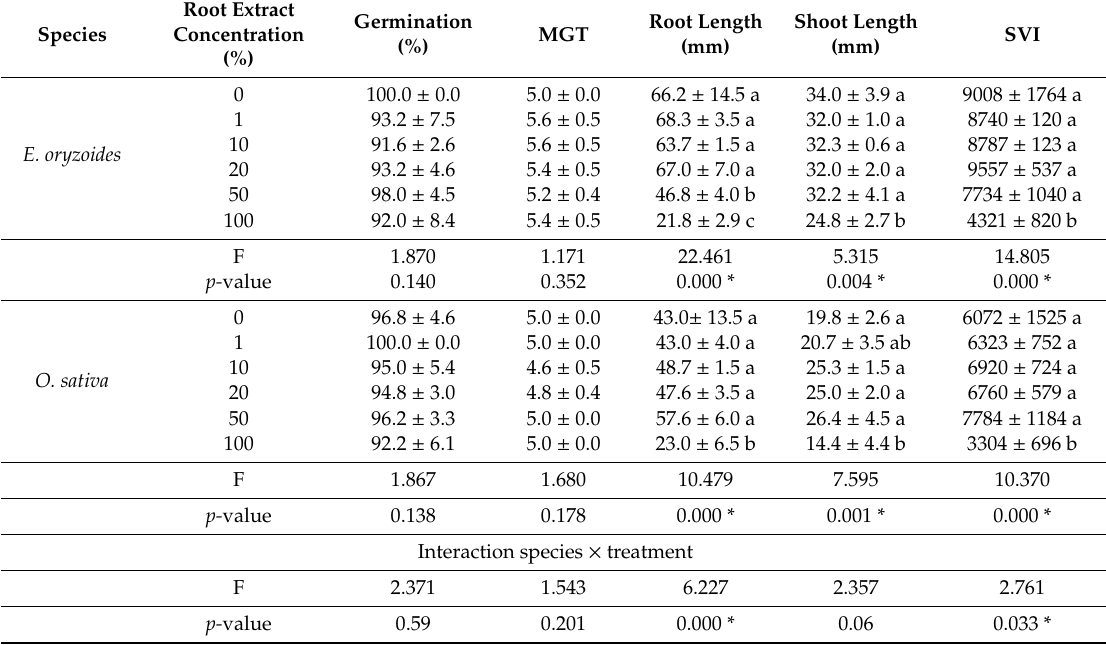
Values are mean ± standard deviation, asterisk and di ff erent letters indicate statistically significant di ff erences at p -value ≤ 0.05 among treatments in each species. F-value and p -value of the ANOVA test. MGT, mean germination time; SVI, seedling vigor